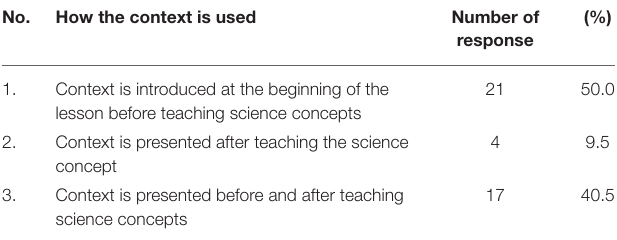
TABLE 5 | The order of using context in